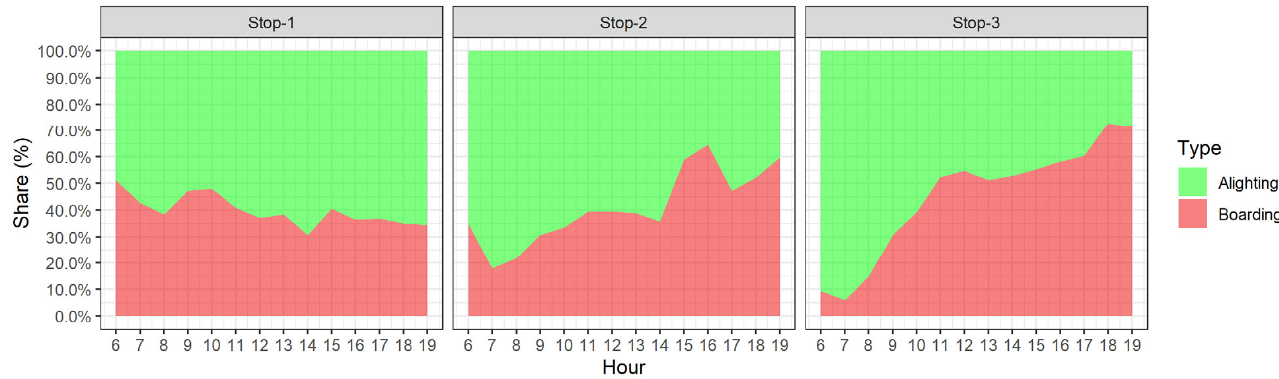
Figure 12. Share of alighting and boarding passengers on each tram stop during the observation period.